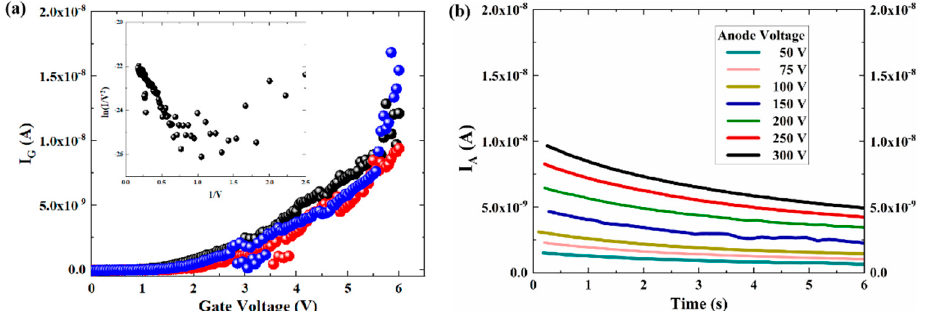
Figure 9. ( a ) Field emission characteristics, inset shows the corresponding F-N fit curve. ( b ) Emission